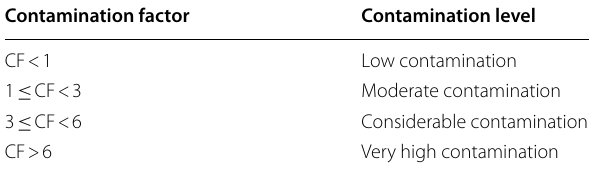
Table 3 Classification of contamination factor